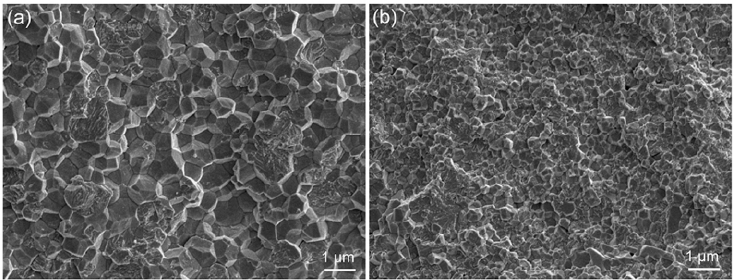
Figure 6. SEM images of the fractured surfaces of the SM ( a ) and SLA ( b ) Y-TZP ceramics after the three-point flexural strength test (magnification = 10,000×; scale bar = 1 μ m).